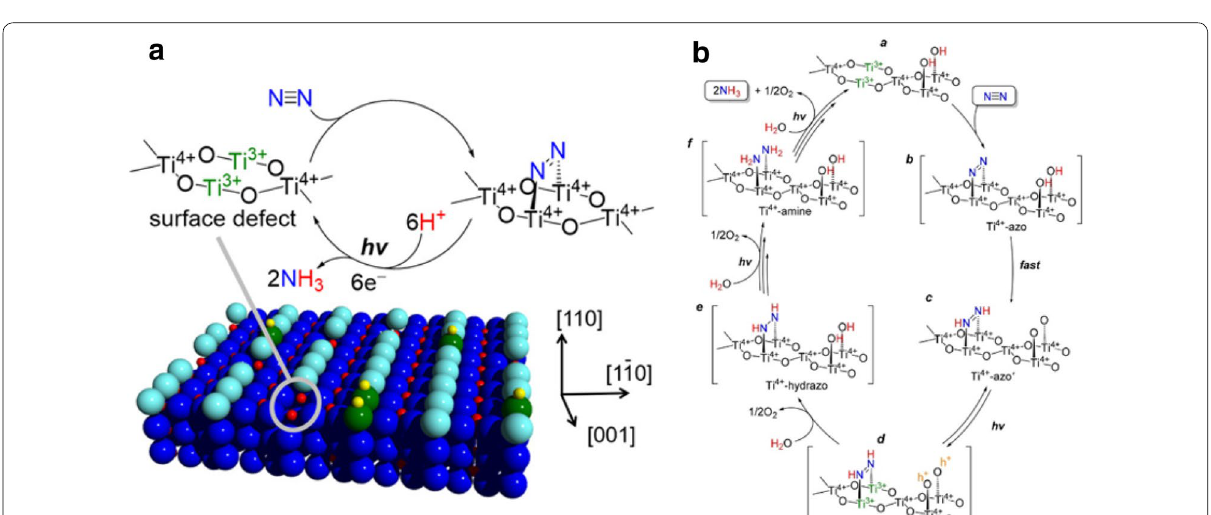
0.4 V (Reproduced with −